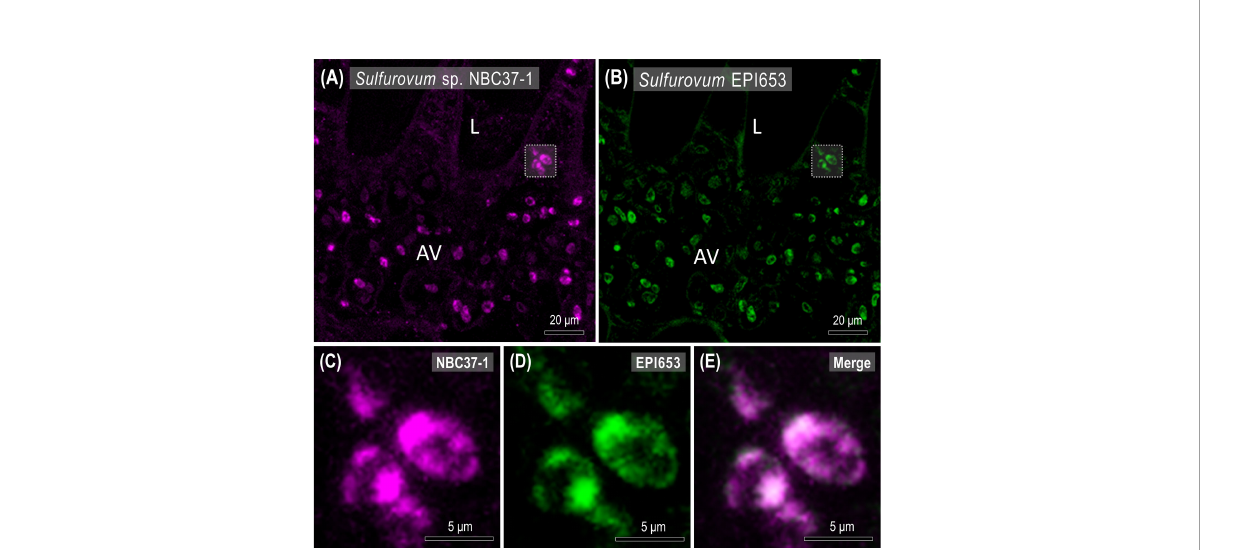
FIGURE 6 Spatial distribution of Sulfurovum sp. NBC37-1 in the gills of X. testudinatus . Fluorescence in situ hybridization (FISH) images show representative Cy5 signals (far-red, Sulfurovum sp. NBC37-1) and Alexa 488 signals (green, Sulfurovum -target probe EPI653) in the transverse sections of gill fi laments. Scale bars = 20 m m (A, B) and 5 m m (C – E) , respectively. L, lamella; AV, afferent vessel.